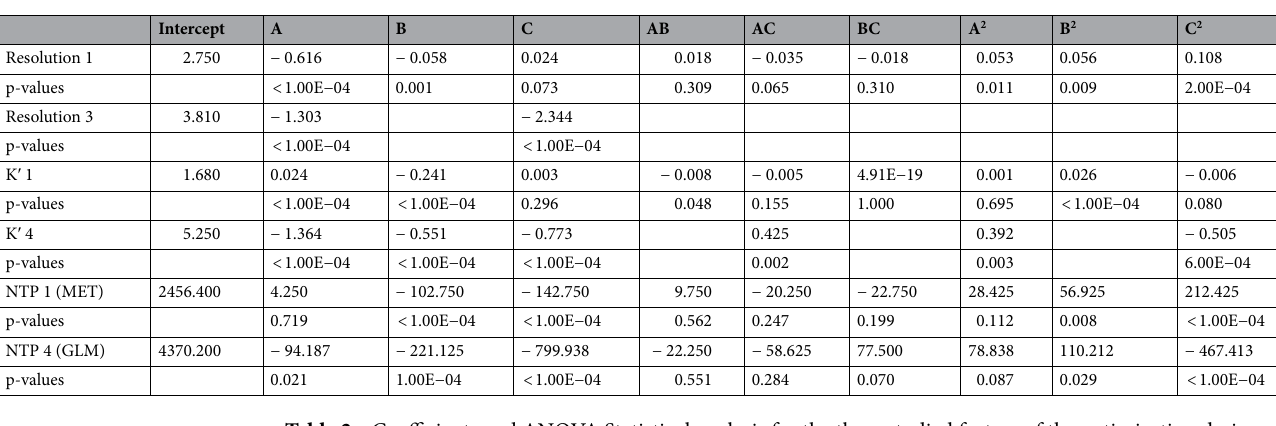
Table 2. Coefficients and ANOVA Statistical analysis for the three studied factors of the optimization design. K ′ : capacity factor; NTP: number of theoretical plates.